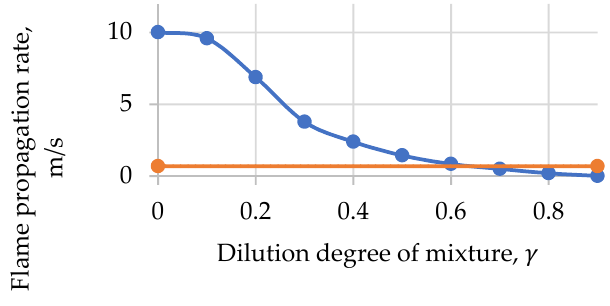
Figure 5. Changes of normal flame propagation rate at a dilution of mixture with water vapor as per Ansys Chemkin-Pro at ϕ = 1.0.